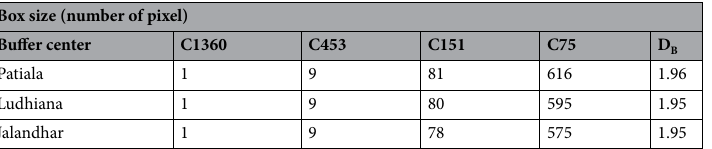
Box size (number of